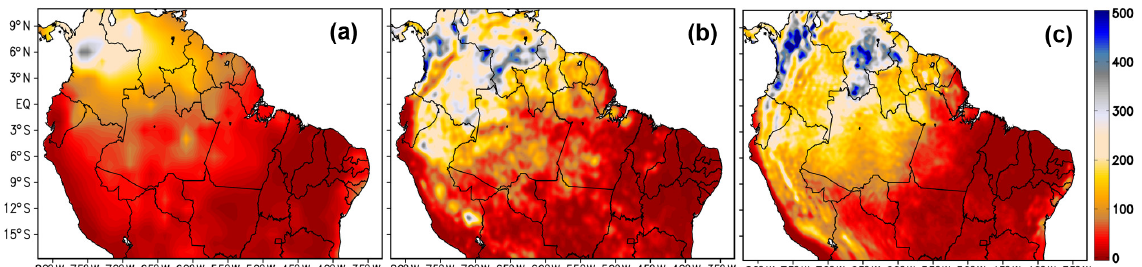
Figure 4. Accumulated precipitation (mm) during September 2010 from the (a) ground station observation network interpolated for the model grid point, (b) TRMM rainfall product, and (c) model